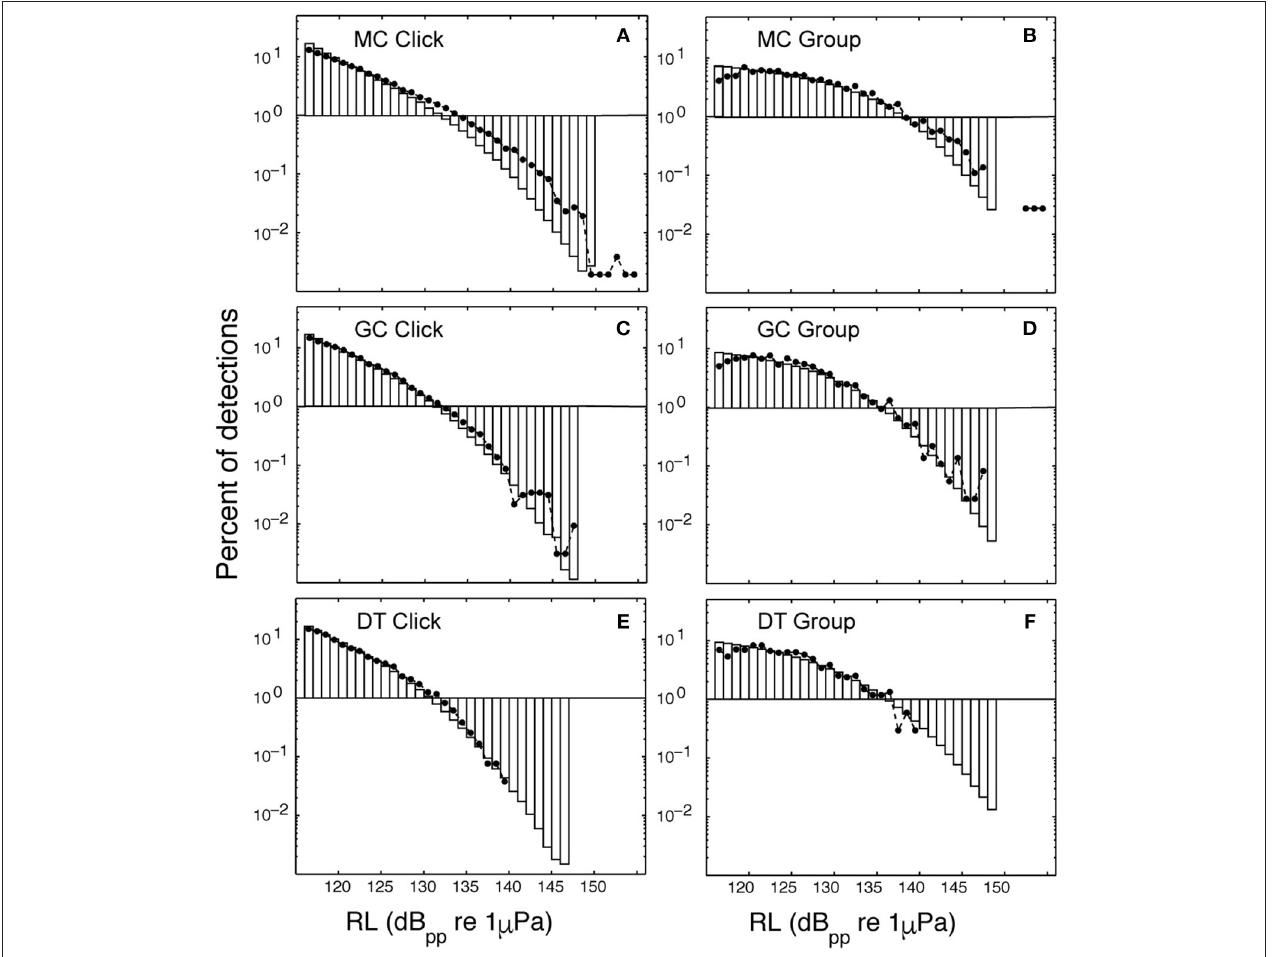
FIGURE 7 | Percentage of modeled acoustic clicks at a given received level (bars) are compared to observed click received levels (dots). Site MC using the click method (A) and the group method (B) ; site GC using the click method (C) and the group method (D) ; and site DT using the click method (E) and the group method (F) . Lower maximum received levels were observed as the depth of the site increased: a maximum received level of 139 dB pp re 1 µ Pa @ 1m was observed at DT with depth of 1,300m (E,F) , however, 155 dB pp re 1 uPa @ 1m was observed at site MC with depth 980m (A,B) .